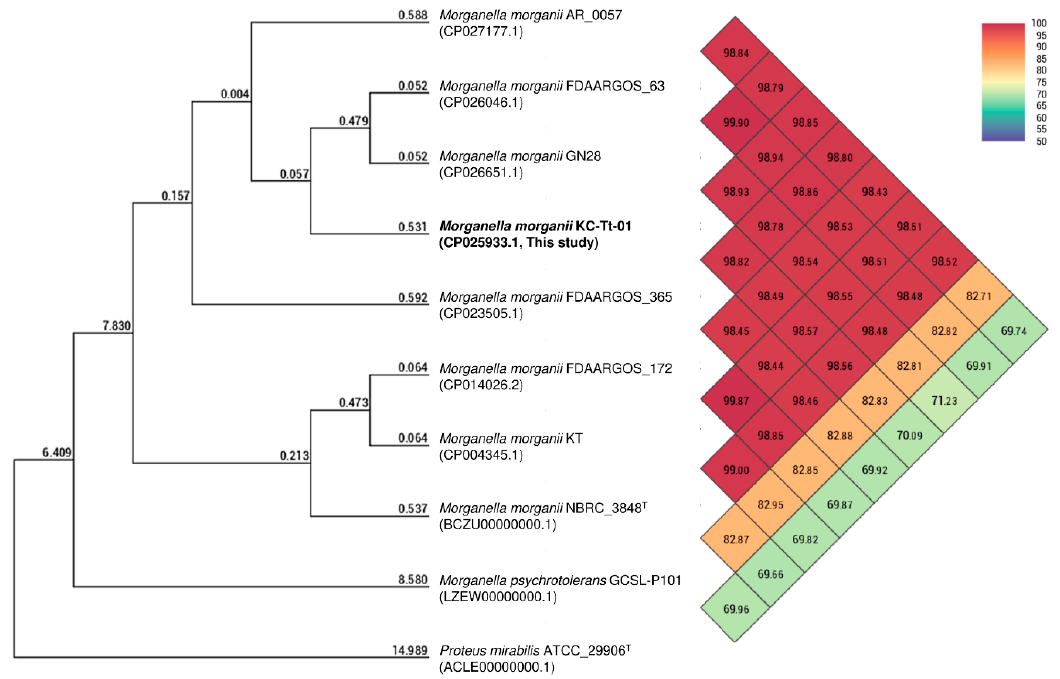
Figure 1. Phylogenetic trees based on the orthologous average nucleotide identity (orthoANI) values calculated using available genomes of Morganella morganii , M. psychrotolerans , and Proteus mirabilis . Comparisons between two strains are given at the junction point of the diagonals departing from each strain; i.e., the OrthoANI value for M. morganii strain KC-Tt-01 (CP025933.1) and strain GN28 (CP026651.1) is 98.93%. (Two-column fitting image).